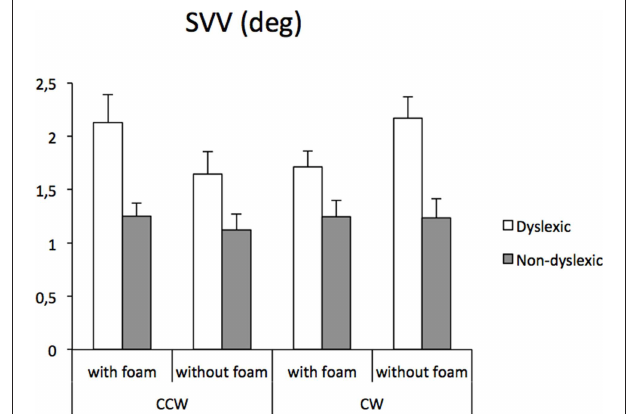
FIGURE 2 | Mean subjective visual vertical and standard error measures (in degree) in children with reading disorder and children with neurotypical development, under two distinct somatosensory conditions (without and with foam under the feet) performed in each tilt direction [clockwise (CW) or counterclockwise